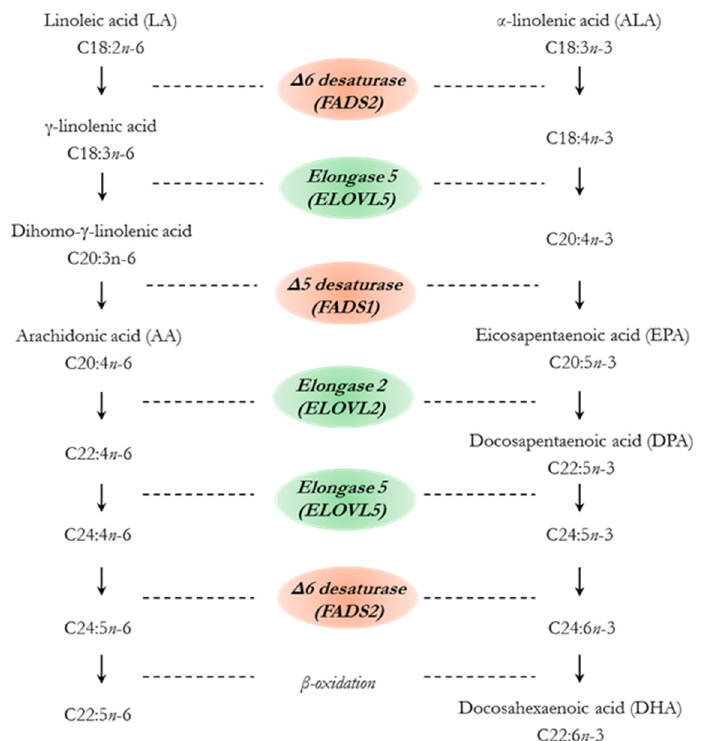
Figure 3. n -6 and n -3 long chain polyunsaturated fatty acid (LCPUFA) biosynthesis pathways from linoleic acid (LA) and α -linolenic acid (ALA) in animals, including ruminants. Adapted from Pereira et al. [33]. ELOVL2 and 5 = fatty acid elongase 2 and 5; FADS1 and 2 = fatty acid desaturase 1 and 2. The fatty acid LA is metabolized to arachidonic acid (AA) (20:4 n -6) through a series of desaturation and elongation reactions. Firstly, LA is desaturated by Δ 6 desaturase (fatty acid desaturase 2 gene, FADS2 ) to γ -linolenic acid (18:3 n -6), which is then elongated by elongase 5 ( ELOVL5 gene) to di-homo- γ -linolenic acid (C20:3 n -6) and subsequently desaturated by Δ 5 desaturase ( FADS1 gene) to AA. Through additional elongations by elongase 2 ( ELOVL2 gene) and elongase 5 ( ELOVL5 gene), a desaturation by Δ 6 desaturase ( FADS2 gene) and a final step of